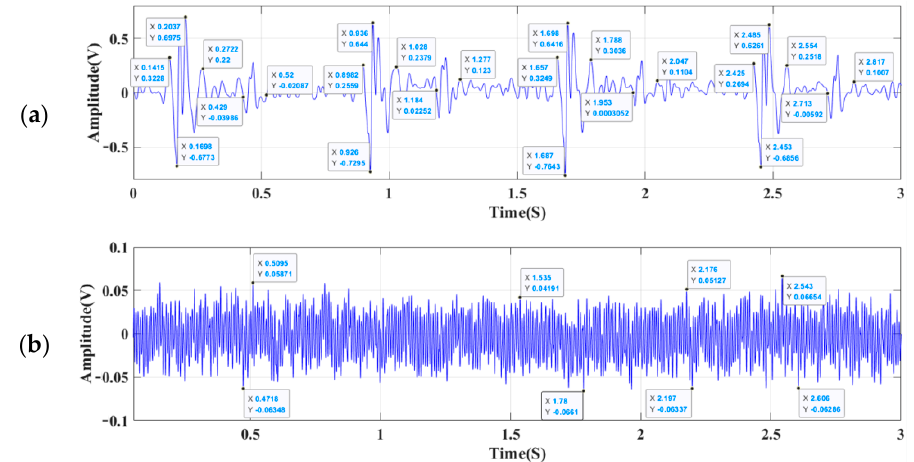
Figure 16. ( a ) The cardiac sound test results for a 3M Littmann 3200 stethoscope. ( b ) The static noise for a 3M Littmann 3200 electronic stethoscope.